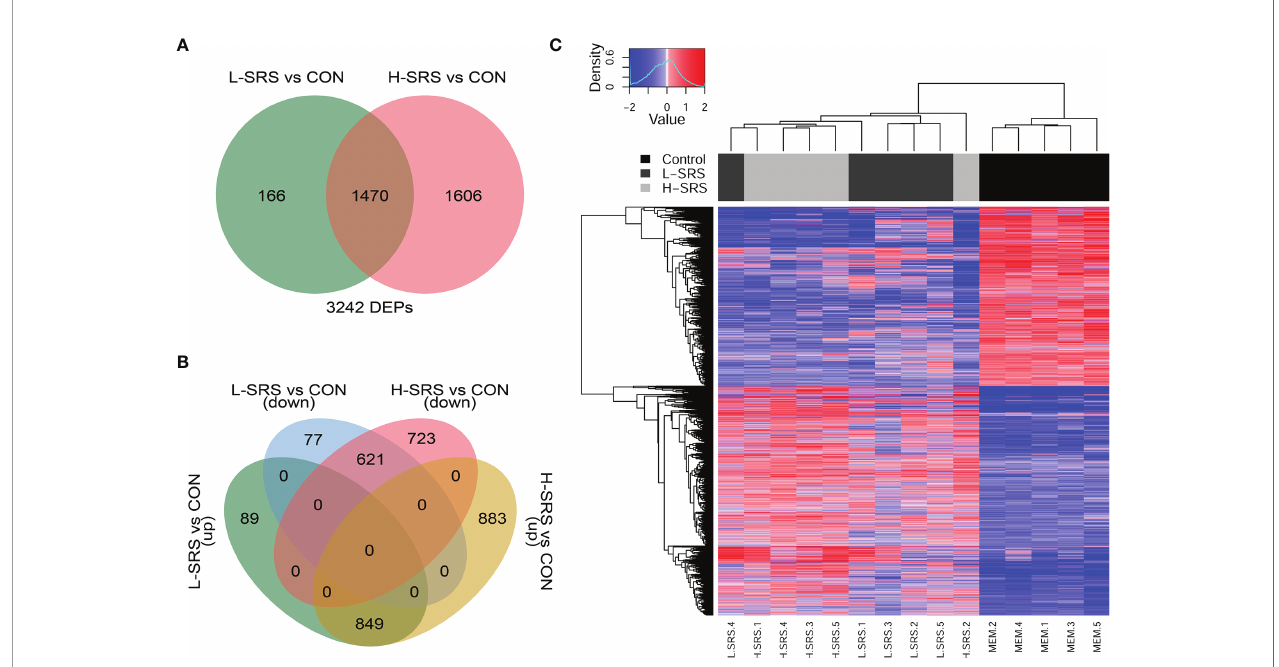
FIGURE 3 | Overview of the head kidney transcriptomic responses of Atlantic salmon with higher (H-SRS) and lower (L-SRS) levels of P. salmonis compared with the control group at 21 days post-injection (DPI). Differentially expressed probes (DEP) were identi fi ed by Signi fi cance Analysis of Microarray (FDR = 1%). (A) Venn diagram illustrates the total number of DEPs in L-SRS or H-SRS groups in comparison to the control fi sh (CON). (B) Venn diagram shows the corresponding number of DEPs that were up- or down-regulated in L-SRS or H-SRS groups in comparison to the control fi sh (CON). (C) Hierarchical clustering analyses of samples based on all P. salmonis responsive probes (n =